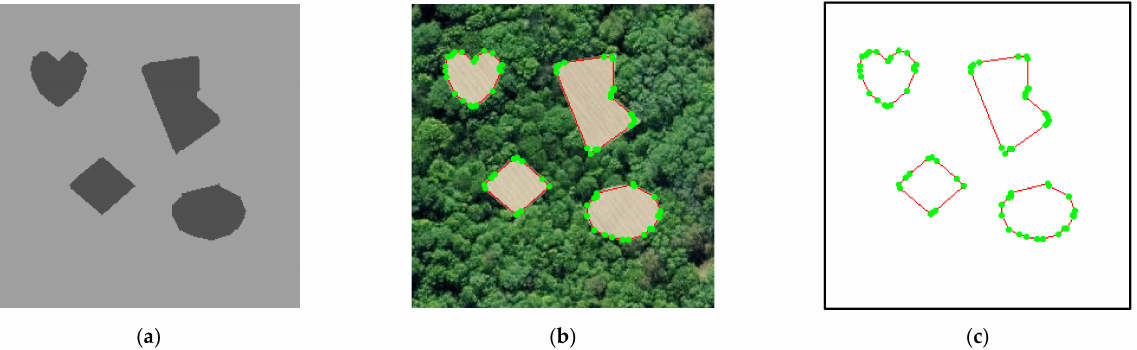
Figure 8. Experimental results of synthetic image: ( a ) Segmentation results; ( b ) Extraction results; ( c ) Extract contour.